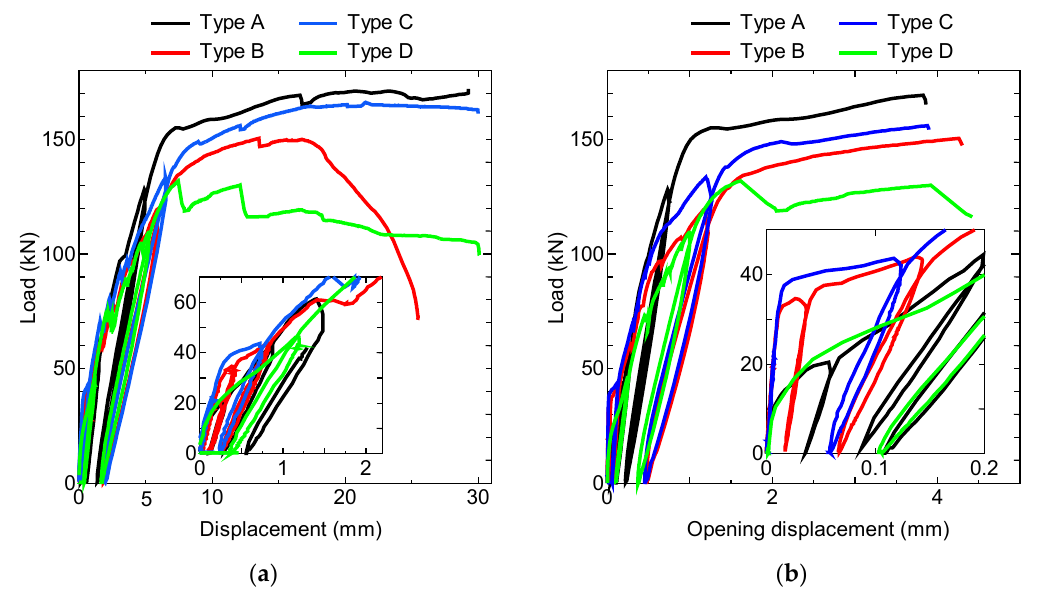
Figure 8. ( a ) Relationship between applied load and deflection at span center; ( b ) relationship between applied load and average crack width at bottom of interface between PCa concrete and joint.